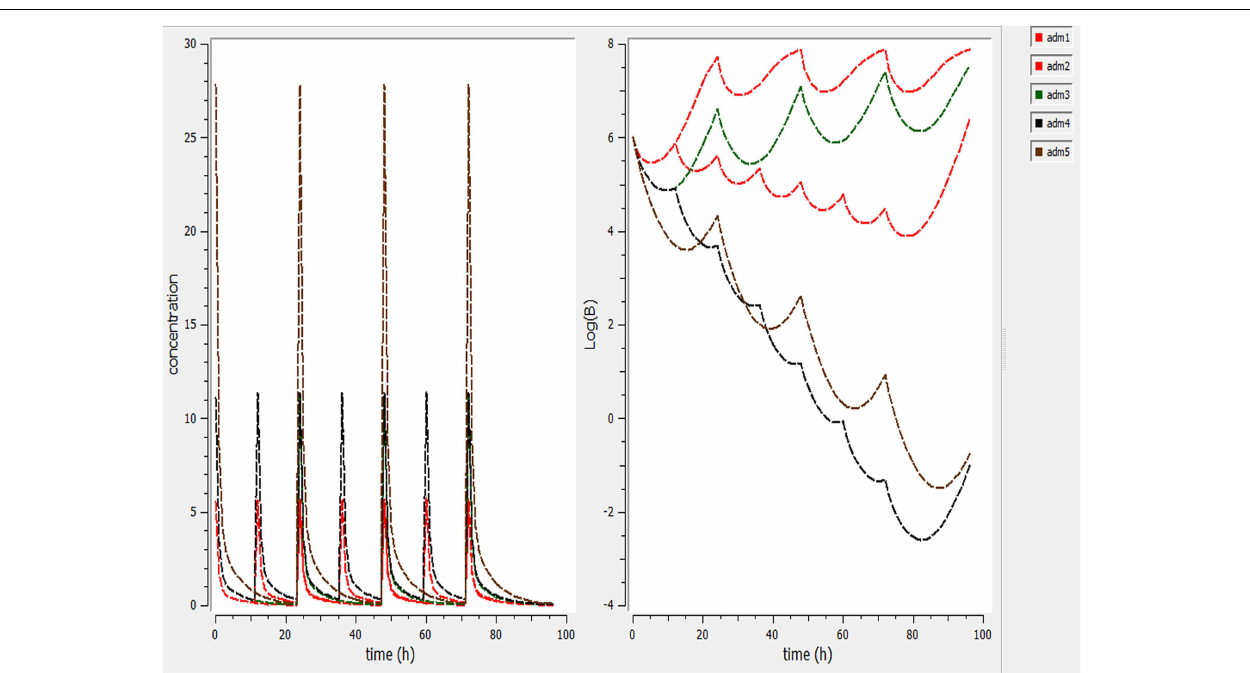
FIGURE 5 | Simulate different dosage regimen (1mg/kg every 12h, 1mg/kg every 24h, and 2mg/kg every 24h, 2mg/kg every 12h, and 5mg/kg every 24 h). The different doses were simulated for different intervals of time to find the efficient dose and dose